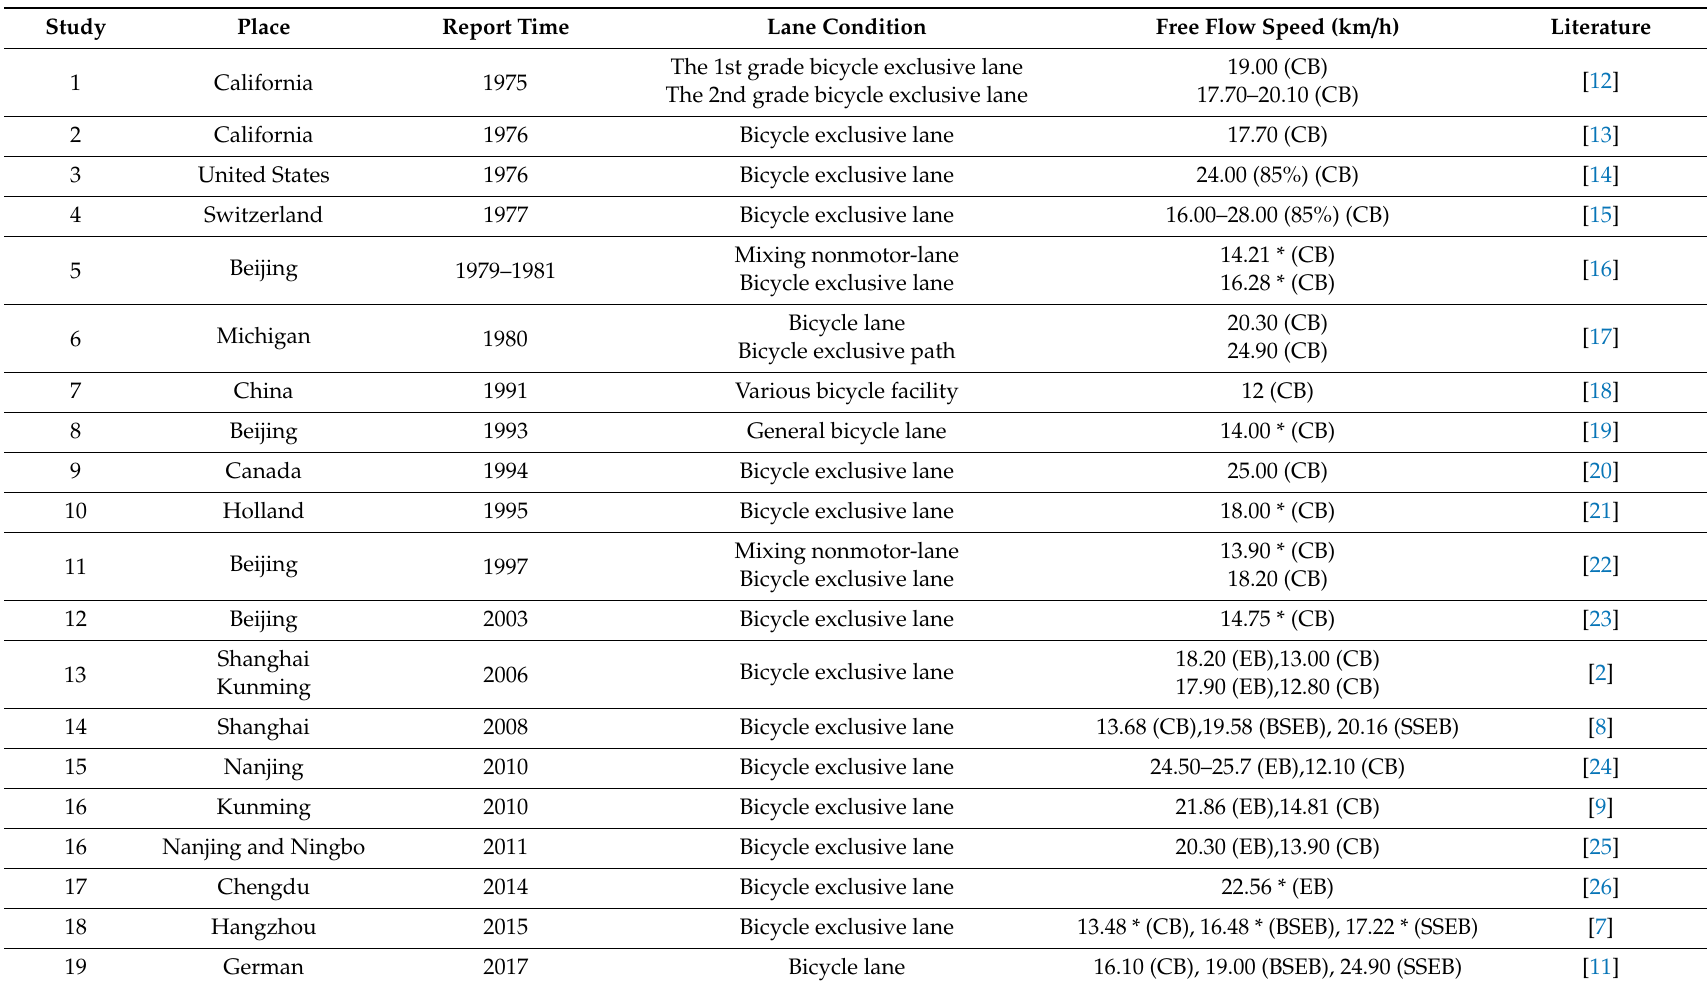
Table 1. Speed of Bicycles from Previous